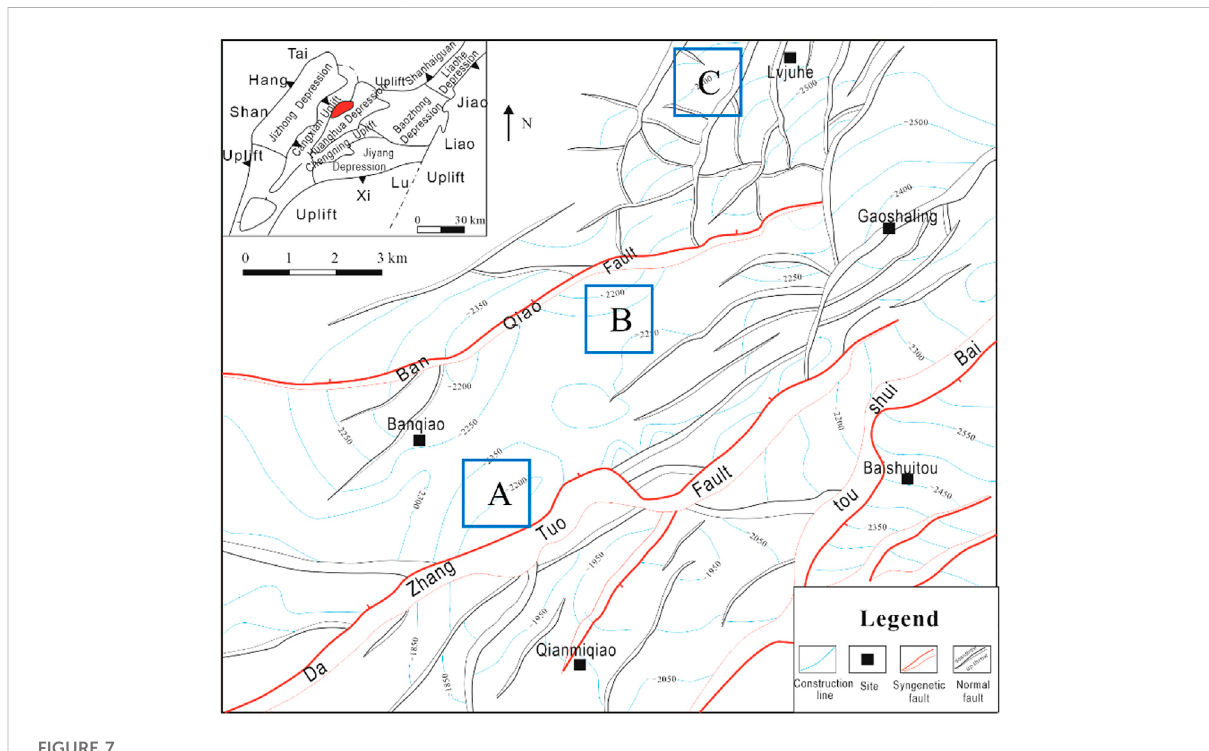
FIGURE 7 Three alternative area